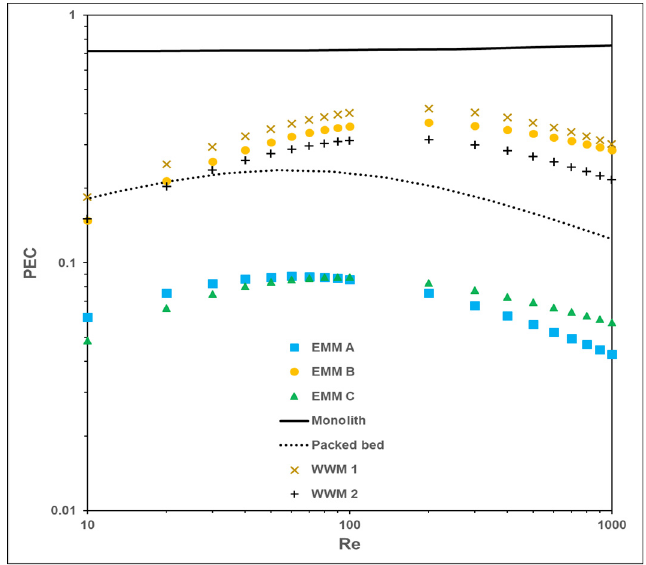
Figure 10. Comparison of Performance Efficiency Criterion of different reactor packings.